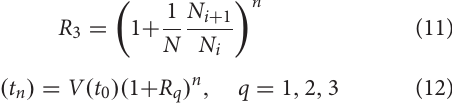
TABLE 1 | Error comparison of each